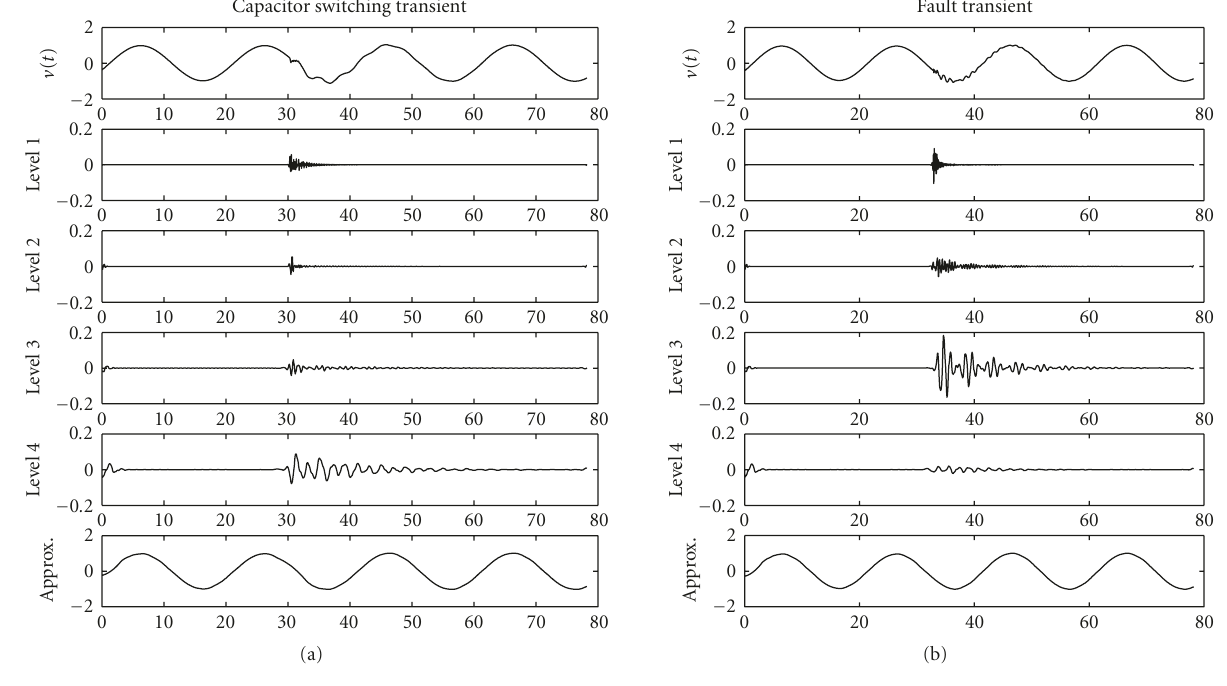
Figure 2: Wavelet expansion of voltage